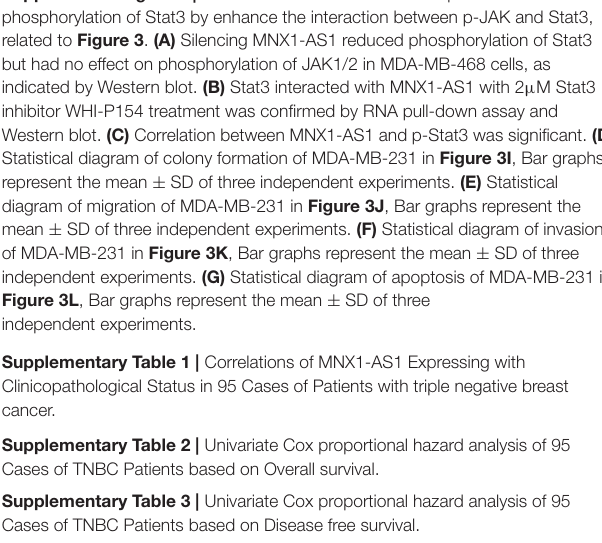
Supplemental Figure 1 | Long non-coding RNA MNX-AS1 is upregulated in triple negative breast cancer (TNBC) and indicates poor survival outcome in breast cancer patients, related to Figure 1 . (A) Association of MNX1-AS1 expression with overall survival (OS) in all breast cancer patients ( n = 626) in the Kaplan-Meier Plotter (KM-Plotter) database with gene chip meta data. (B) Association of MNX1-AS1 expression with relapse-free survival (RFS) in all breast cancer patients ( n = 654) in the Kaplan-Meier Plotter (KM-Plotter) database with gene chip meta data. (C) Association of MNX1-AS1 expression with relapse-free survival (RFS) in TNBC patients ( n = 654) in the Kaplan-Meier Plotter (KM-Plotter) database with gene chip meta data. (D) The representative image of low and high MNX1-AS1 expression in TNBC patients. (E) In situ hybridization (ISH) score of MNX1-AS1 in paraffin-embedded sections of paired breast cancer and adjacent normal tissues of 66 patients. Supplemental Figure 2 | MNX1-AS1 promotes progress of breast cancer in vitro , related to Figure 2 . (A) MNX1-AS1 mainly expressed in cytoplasm in MDA-MB-231 cells, as indicated by nuclear/Cytosol Fractionation assay. Bar graphs represent the mean ± SD of three independent experiments. (B) Statistical diagram of colony formation of MDA-MB-231 in Figure 2D , Bar graphs represent the mean ± SD of three independent experiments. (C) Statistical diagram of migration of MDA-MB-231 in Figure 2E , Bar graphs represent the mean ± SD of three independent experiments. (D) Statistical diagram of invasion of MDA-MB-231 in Figure 2F , Bar graphs represent the mean ± SD of three independent experiments. (E) MNX1-AS1 regulated epithelial-mesenchymal transition (EMT) rather than MMP7, as indicated by Western blot. (G) Statistical diagram of apoptosis of MDA-MB-231 in Figure 2G , Bar graphs represent the mean ± SD of three independent experiments. Supplemental Figure 3 | MNX1-AS1 interacts State3 and promotes phosphorylation of Stat3 by enhance the interaction between p-JAK and Stat3, related to Figure 3 . (A) Silencing MNX1-AS1 reduced phosphorylation of Stat3 but had no effect on phosphorylation of JAK1/2 in MDA-MB-468 cells, as indicated by Western blot. (B) Stat3 interacted with MNX1-AS1 with 2 µ M Stat3 inhibitor WHI-P154 treatment was confirmed by RNA pull-down assay and Western blot. (C) Correlation between MNX1-AS1 and p-Stat3 was significant. (D) Statistical diagram of colony formation of MDA-MB-231 in Figure 3I , Bar graphs represent the mean ± SD of three independent experiments. (E) Statistical diagram of migration of MDA-MB-231 in Figure 3J , Bar graphs represent the mean ± SD of three independent experiments. (F) Statistical diagram of invasion of MDA-MB-231 in Figure 3K , Bar graphs represent the mean ± SD of three independent experiments. (G) Statistical diagram of apoptosis of MDA-MB-231 in Figure 3L , Bar graphs represent the mean ± SD of three independent experiments.